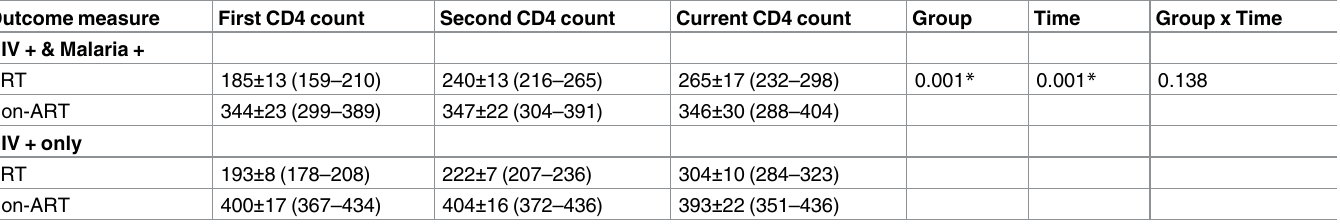
Table 5. Changes in CD4+ T Cell Count Between Co-infected and Non-Co-Infected HIV Patients Attending ART Clinic at Infectious DiseaseHospi- tal Kano Between June to December2015 (n = 761). Outcome measure First CD4 count HIV + & Malaria